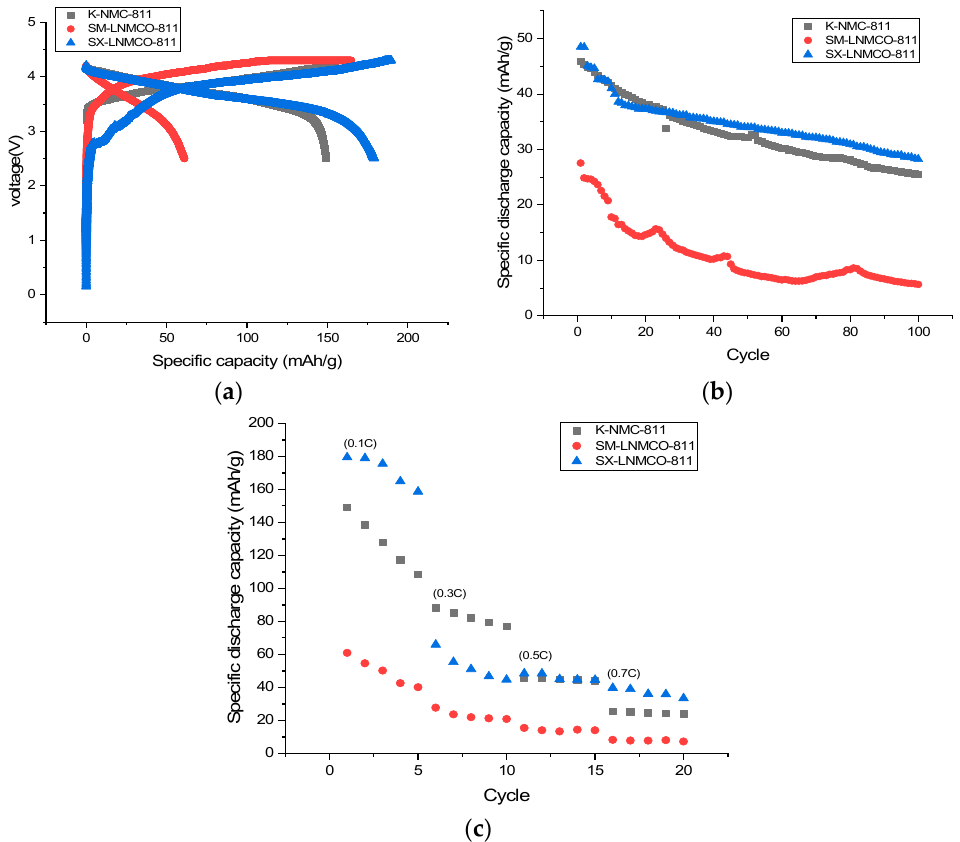
Figure 5. ( a ) Charge–discharge profiles of the batteries with cathode precursor variations, ( b ) profiles of specific discharge capacities (mAh/g) of the batteries for 100 testing cycles, ( c ) rate capability of material variation NMC ‐ 811. Table 8. Results of the charge–discharge measurements of the fabricated batteries with